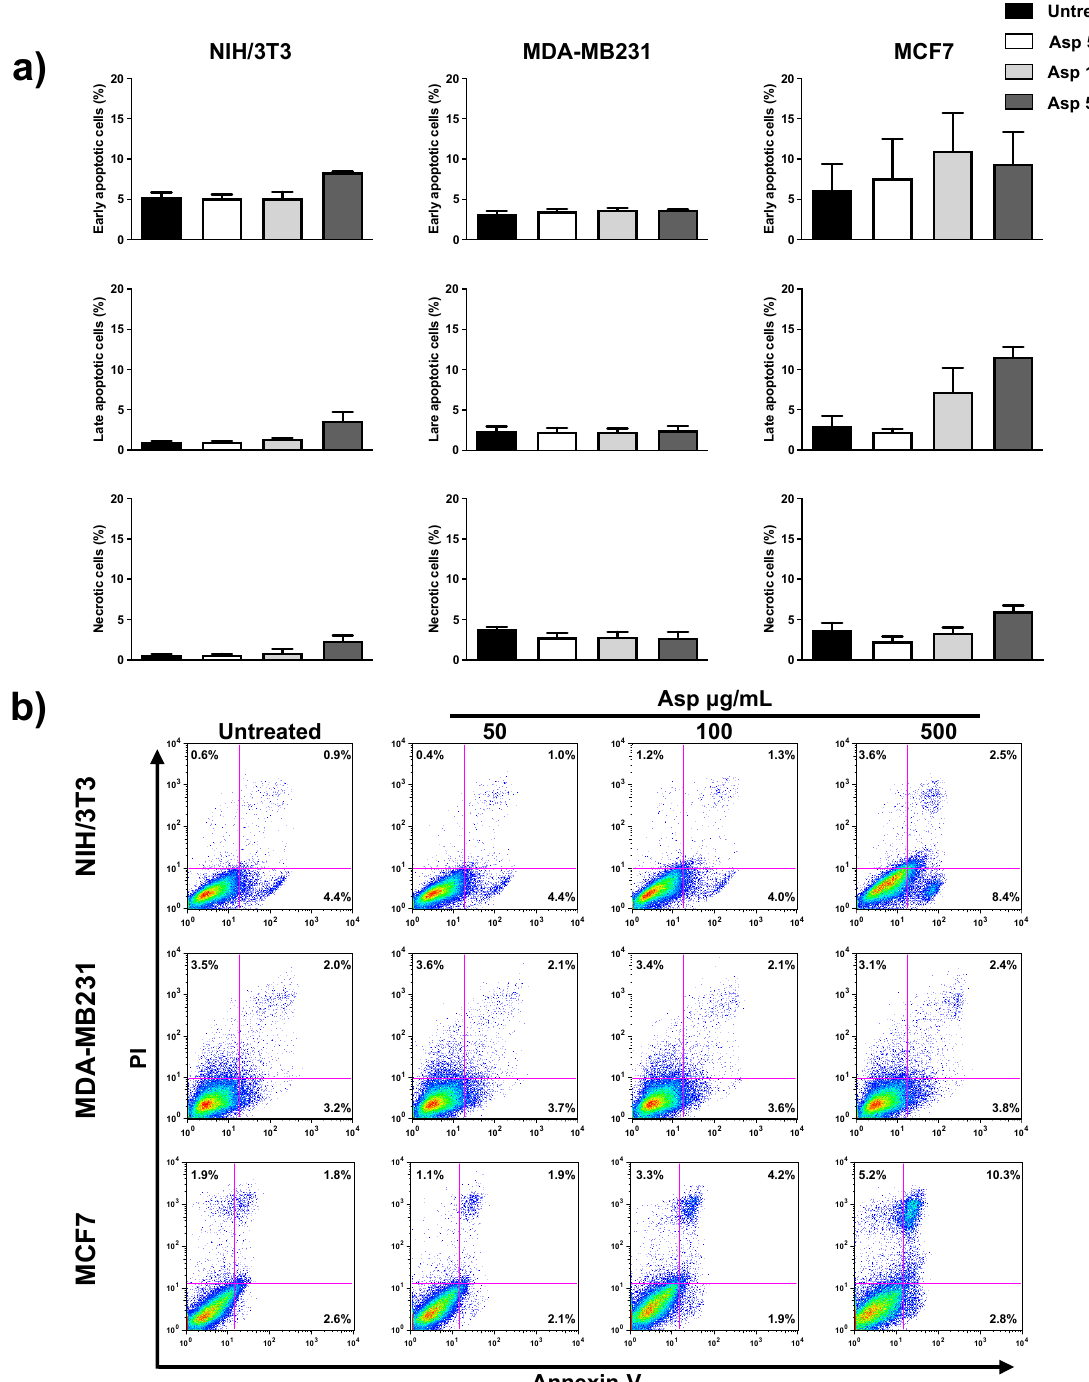
Figure 3. NIH/3T3; MDA-MB231; MCF7 percentage of apoptotic cells after 48 h, calculated from the flow cytometry dot plots after Annexin V/PI staining. ( a ) Results from untreated or treated with 50, 100, and 500 μ g/mL Asp extracts were expressed as a percentage of the total population. Data are reported as mean ± standard error from three independent experiments. ( b ) Representative flow cytometry dot plots. The axis scales for fluorescence are reported as logarithmic .